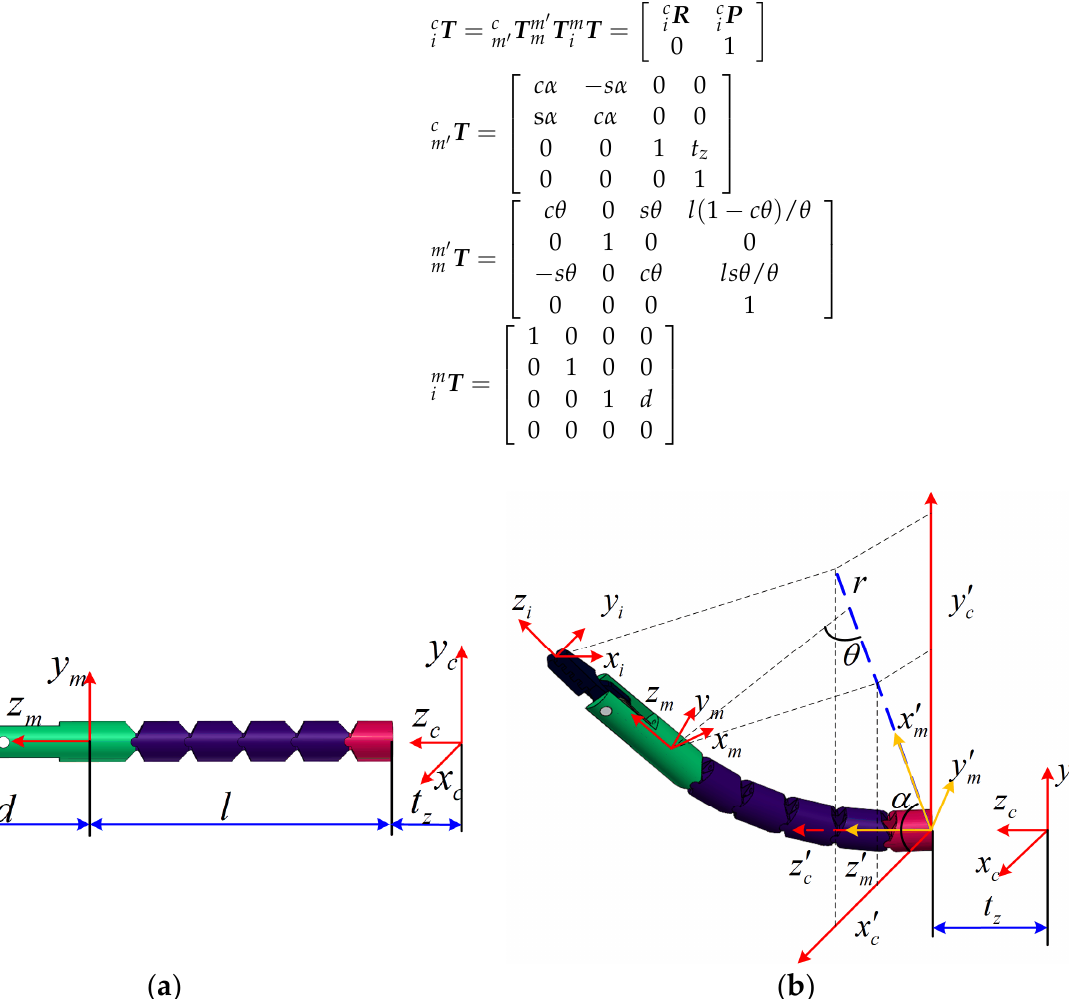
Figure 4. ( a ) Kinematics analysis of manipulator when its bending angle was zero; ( b ) kinematics analysis of manipulator when its bending angle was not zero.